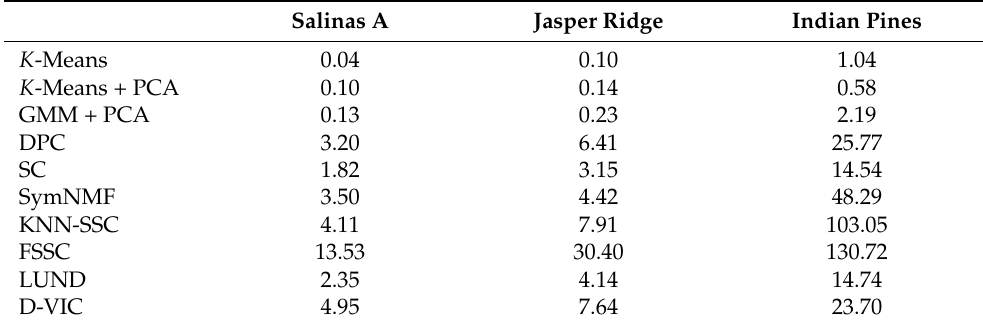
Table 3. Runtimes (seconds) of D-VIC and related algorithms. D-VIC achieves runtimes comparable to state-of-the-art algorithms and scales well to the larger Indian Pines dataset.